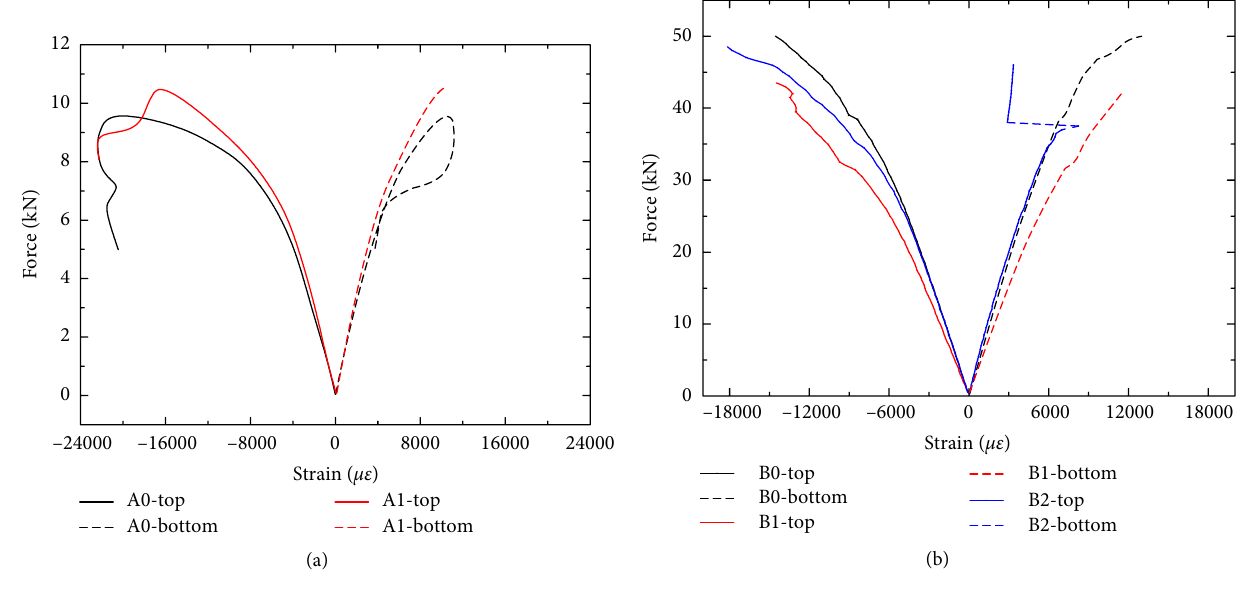
Figure 12: Load–strain curves: (a) first series and (b) second